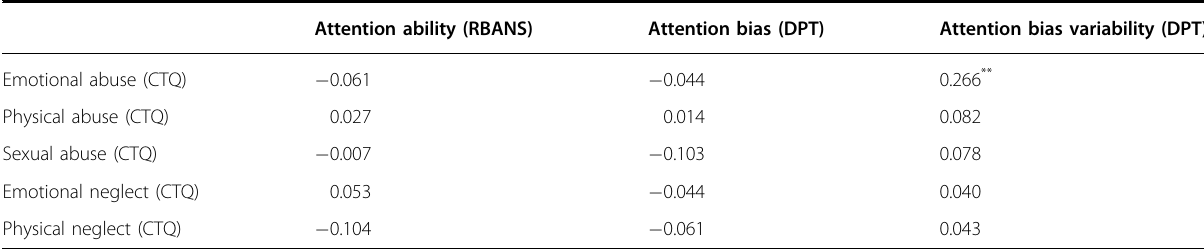
Table 2 Correlations between childhood maltreatment and attention indices in total participants ( n = 128).